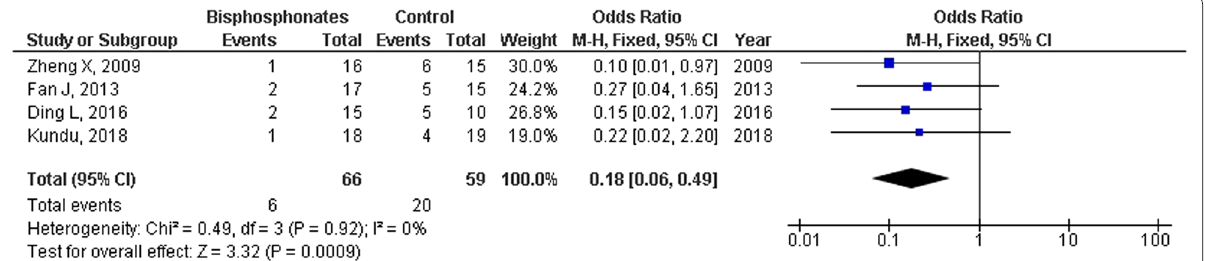
Fig. 5 The forest plot of the results of intralesional curettage in patients with giant cell tumors of the bone after the effects of bisphosphonates were compared to those of a control group